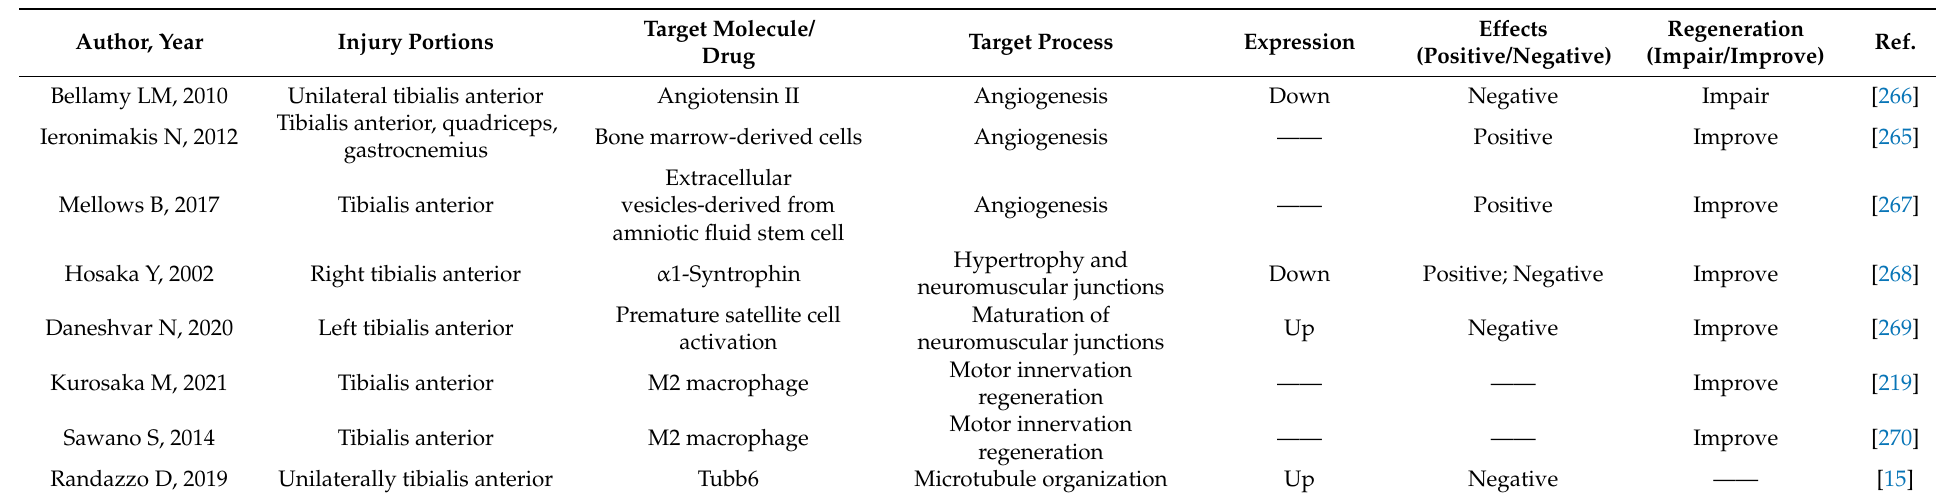
Table 5. Angiogenesis and neurogenesis in CTX-induced injury